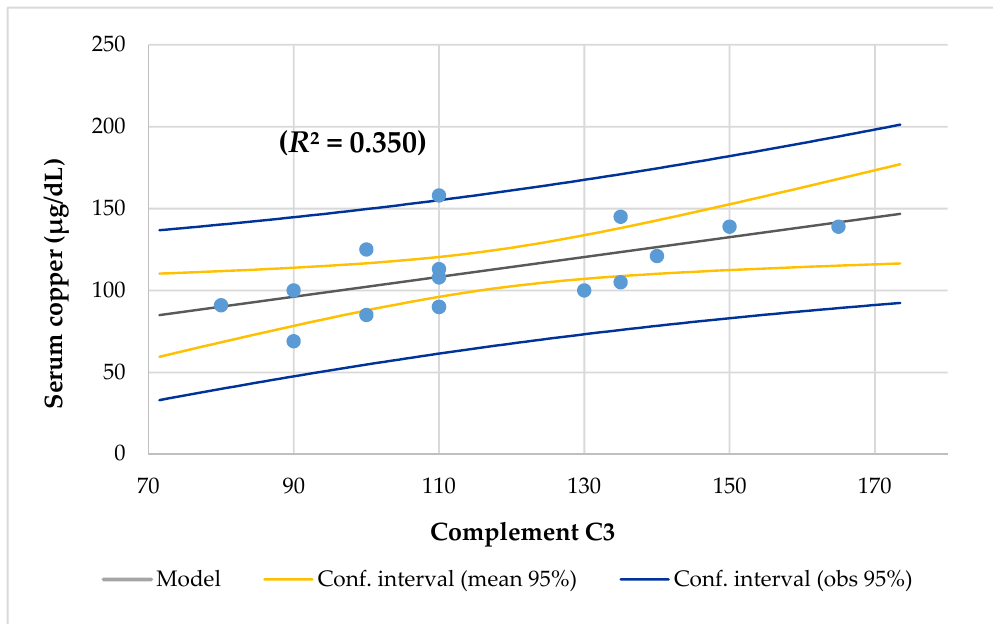
Figure 4. Regression serum copper by complement C3.